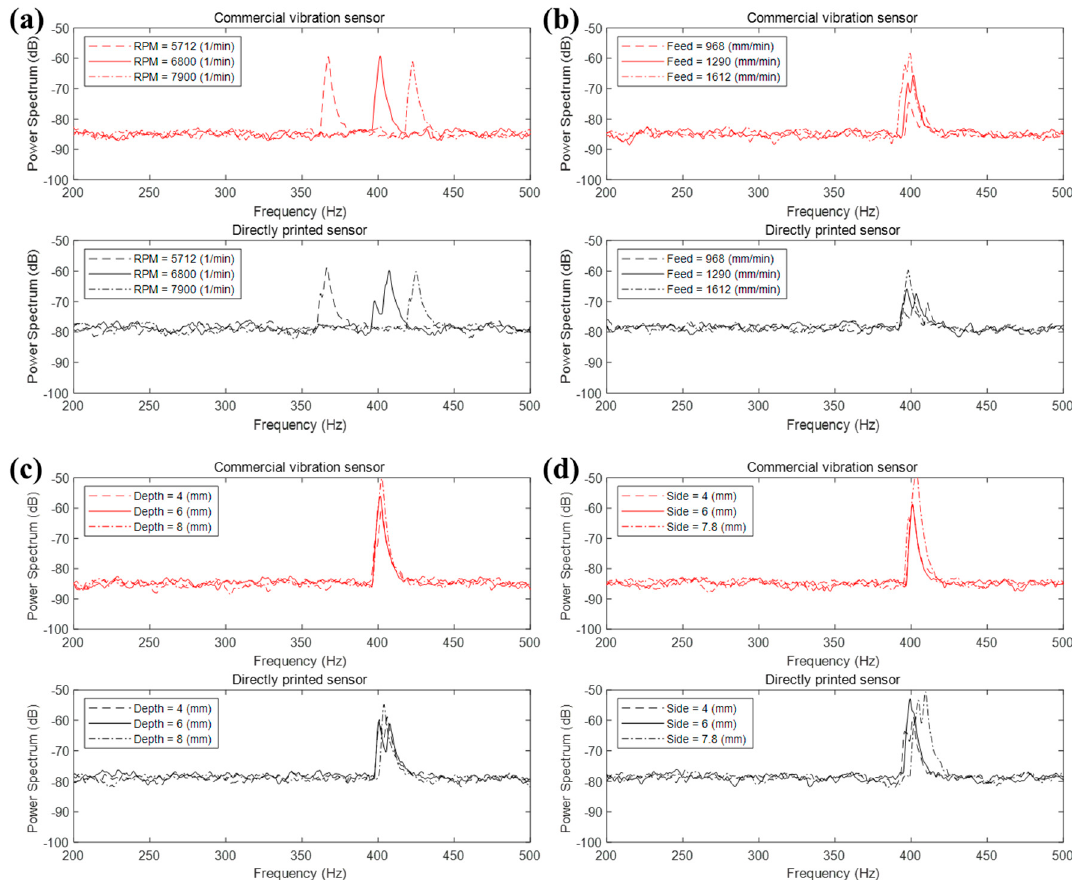
Figure 8. Power spectrum according to the process parameter. ( a ) RPM, ( b ) feed rate, ( c ) cutting depth, and ( d ) cutting side.